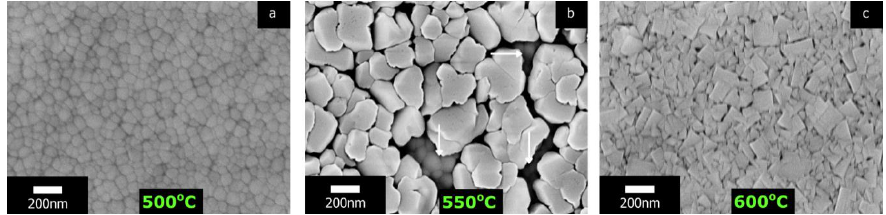
Figure 4. SEM images of films deposited at ( a ) 500 °C; ( b ) 550 °C; ( c ) 600 °C substrate temperatures. The cross-section view of PZT film deposited at 550 ◦ C is displayed in Figure 5. It shows a dense formation of the film with vertical shadows, which indicate the column growth. The columns are uniform, with no visible embedded pyrochlore structures; thus, they can be formed at the PZT/Pt interface, as seen in Figure 4b. The film thickness reaches Coatings 2022 , 12 , x FOR PEER REVIEW ~500 nm, which agrees with the measurements by the profilometer.